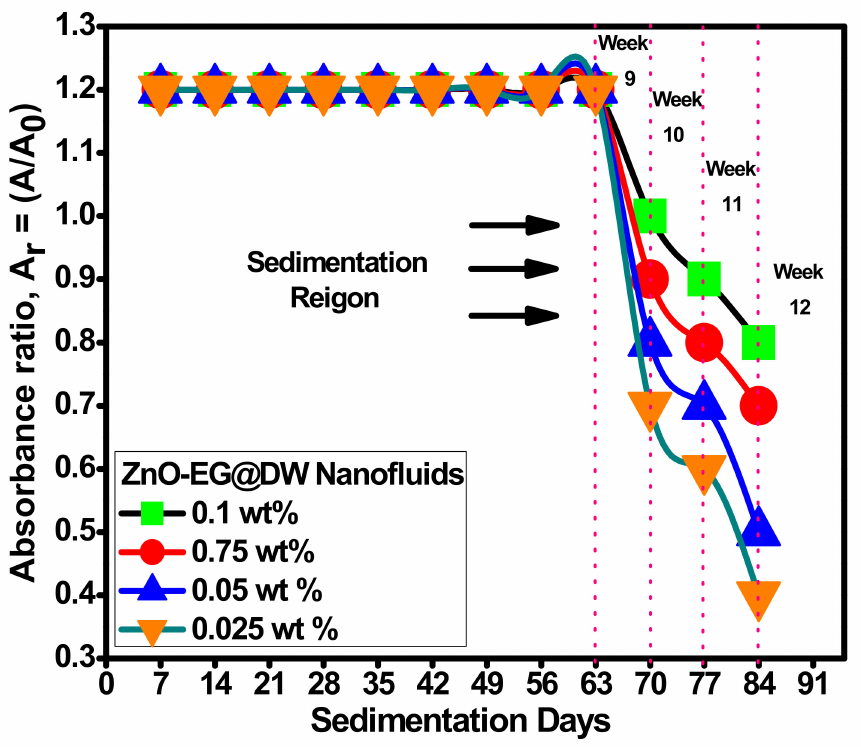
Figure 10. Sedimentation analysis of ZnO-EG@DW nanofluids with different wt.% of ZnO in EG@DW base